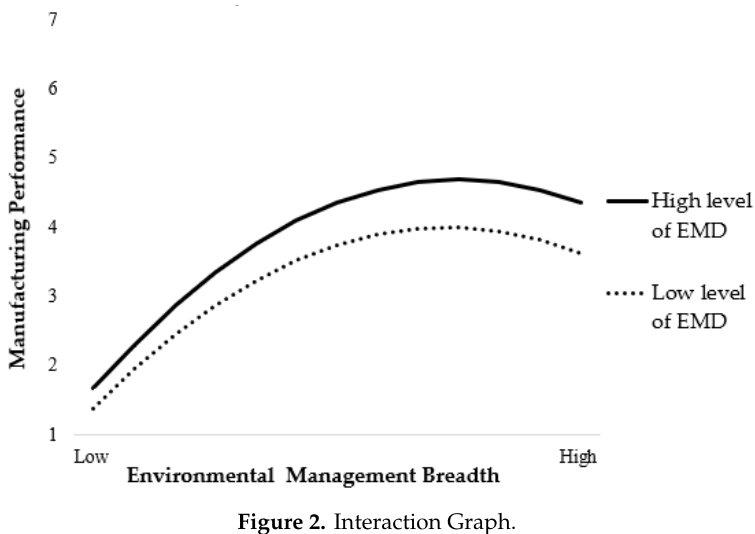
Figure 2. Interaction Graph.